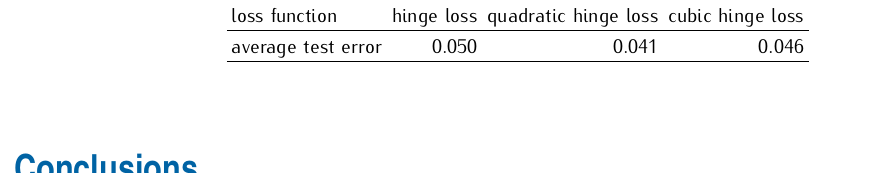
10 -fold cross validation for each loss